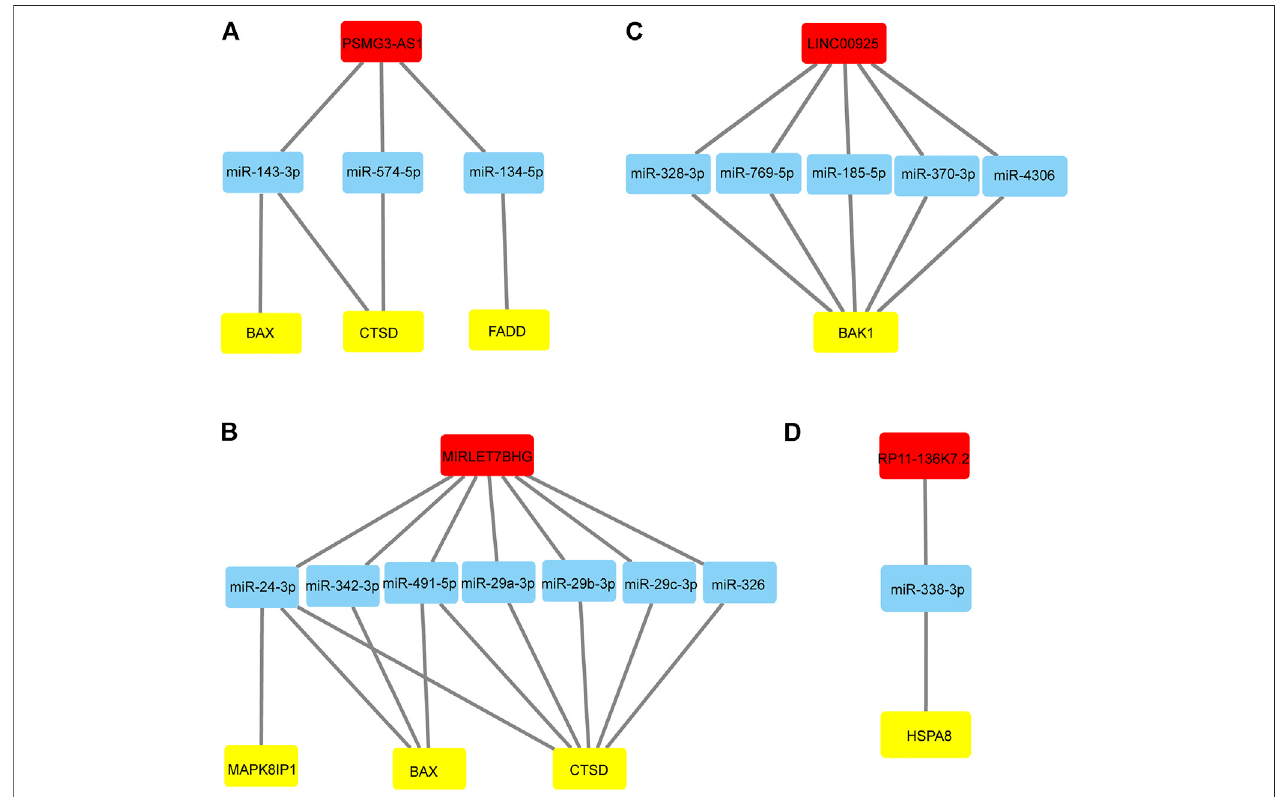
FIGURE5| lncRNA-miRNA-mRNAregulatorynetworks (A) LncRNA PSMG3-AS1 anditsbindingmiRNAs andthecorresponding regulationofautophagy-related genes. (B) LncRNA MIRLET7BHG and its binding miRNAs and the corresponding regulation of autophagy-related genes. (C) LncRNA LINC00925 and its binding miRNAs and the corresponding regulation of autophagy-related genes. (D) LncRNA RP11-136K7.2 and its binding miRNAs and the corresponding regulation of autophagy-related